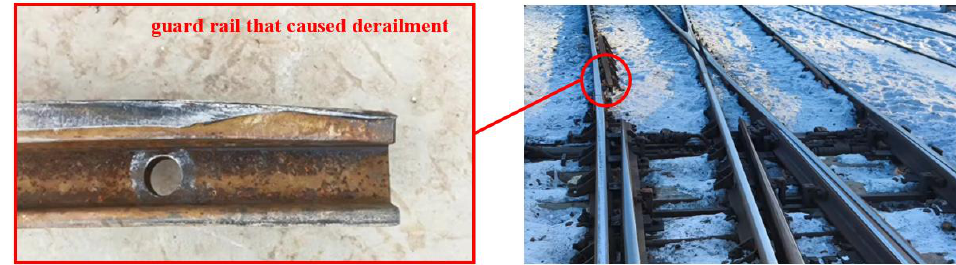
Figure 1. Schematic of derailment at the guardrail position in double-slip turnout.